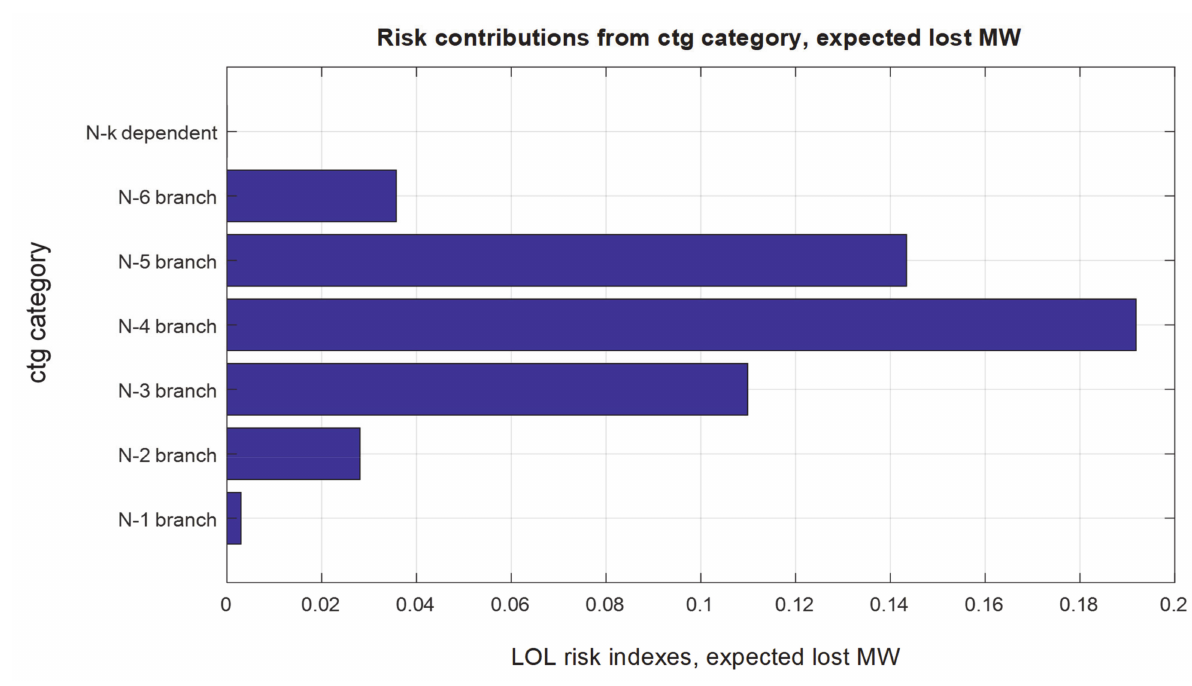
Figure 10. Contributions of contingency orders to the total LOL risk, case